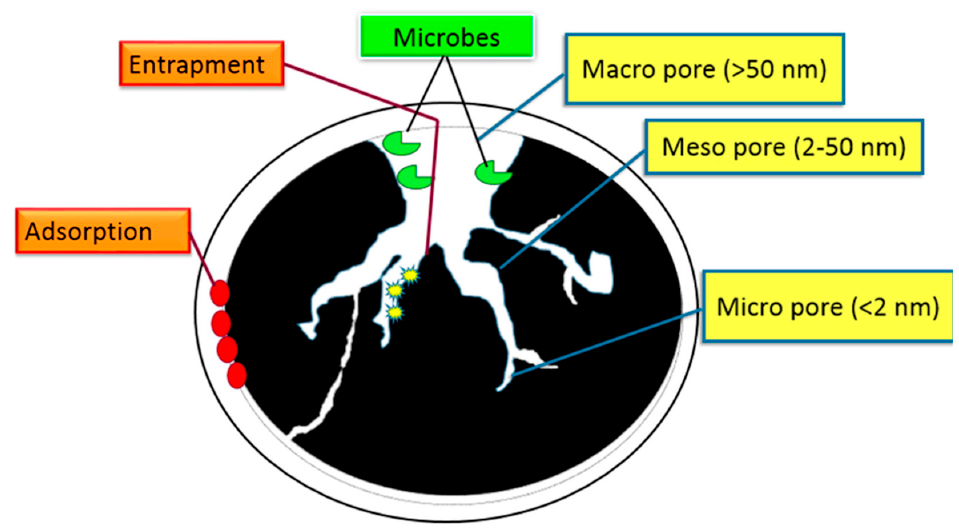
Figure 1. Illustration of pore distribution